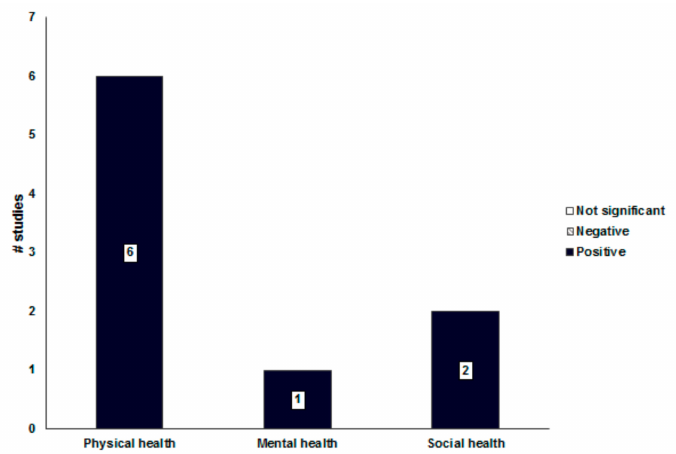
Figure 3. Associations between the street environment and health-related